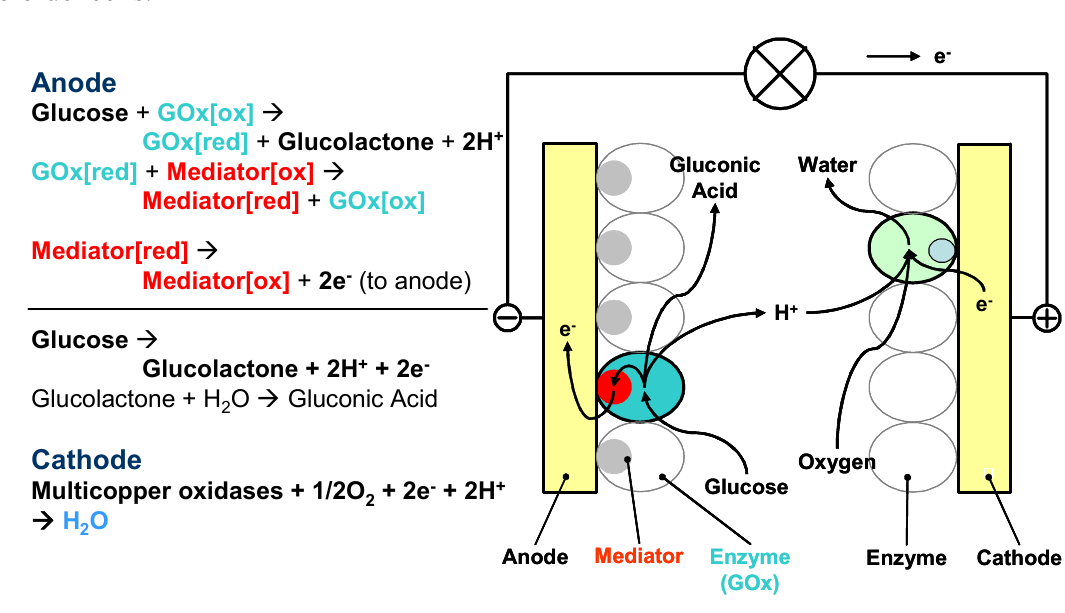
Figure 3. Schematic diagram of work principle for mediated electron transfer in enzymatic biofuel